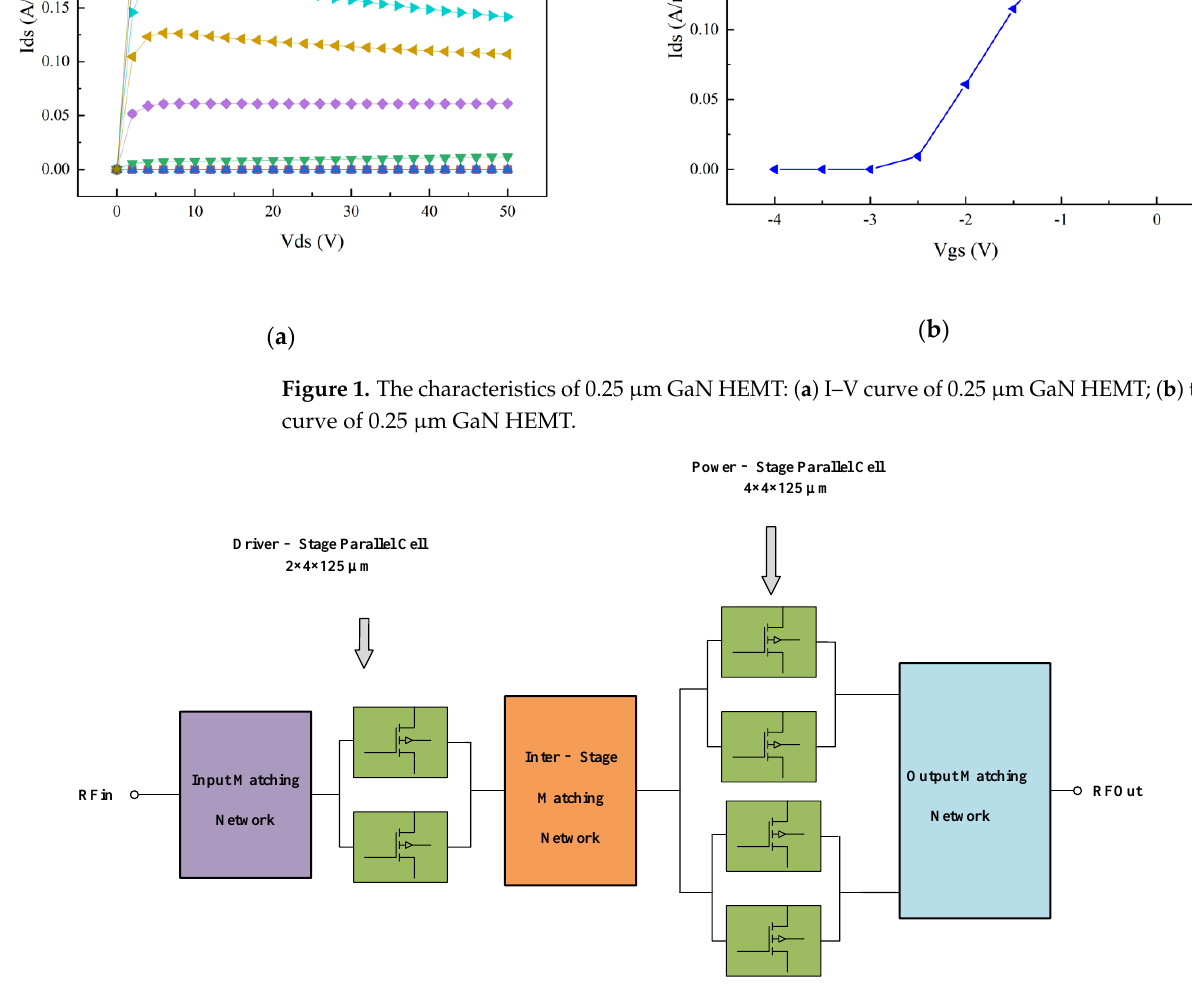
Figure 2. The circuit structure block diagram of the 7-13 GHz MMIC PA design.